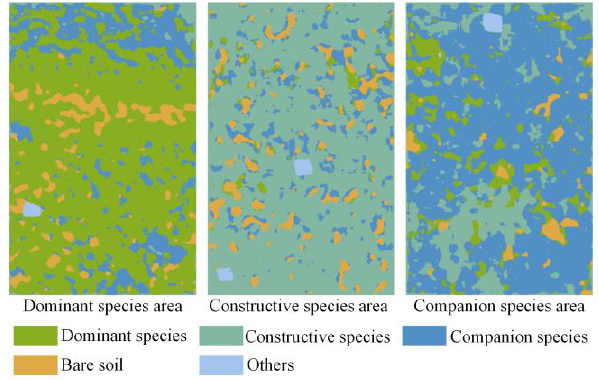
Figure 10. Classification visualization results.